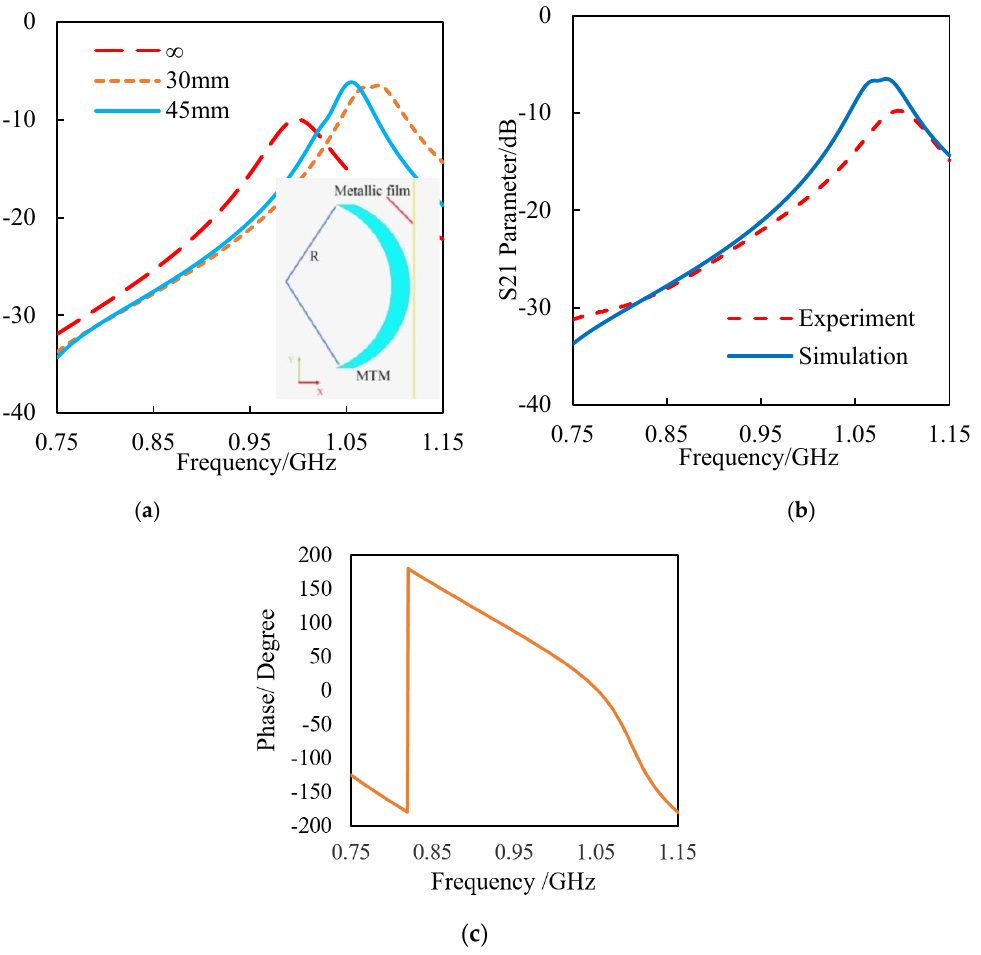
Figure 7. ( a ) The simulated S 21 parameters with curved MTM with different curvature radius. ( b ) The simulated and tested magnitude of S 21 parameters and ( c ) the simulated phase of S 21 parameters when the curvature radius of the MTM particle was 30 mm.